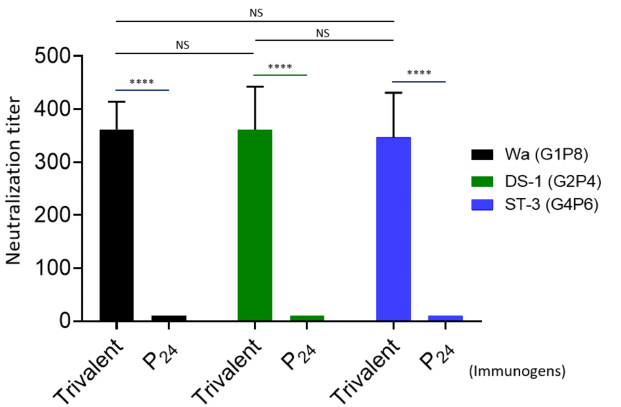
Figure 6. Neutralization of the P 24 -VP8* nanoparticle trivalent vaccine-immunized mouse sera against three homologous rotavirus P types. The 50% neutralization titers (Y-axis) of mouse sera after administration with the trivalent vaccine (trivalent) against a P[8] (Wa strain, G1P8, black columns), a P[4] (DS-1 strain, G2P[4], green columns), and a P[6] (ST-3, G4P6, blue columns) rotavirus in cell culture are shown and compared each other using the mouse sera after immunization with the P 24 nanoparticles without the VP8* antigens (P 24 ) as controls (X-axis). Statistical differences between data groups are indicated as “ns” for non-significant for p -values > 0.05, and **** for extremely significant for p -values <